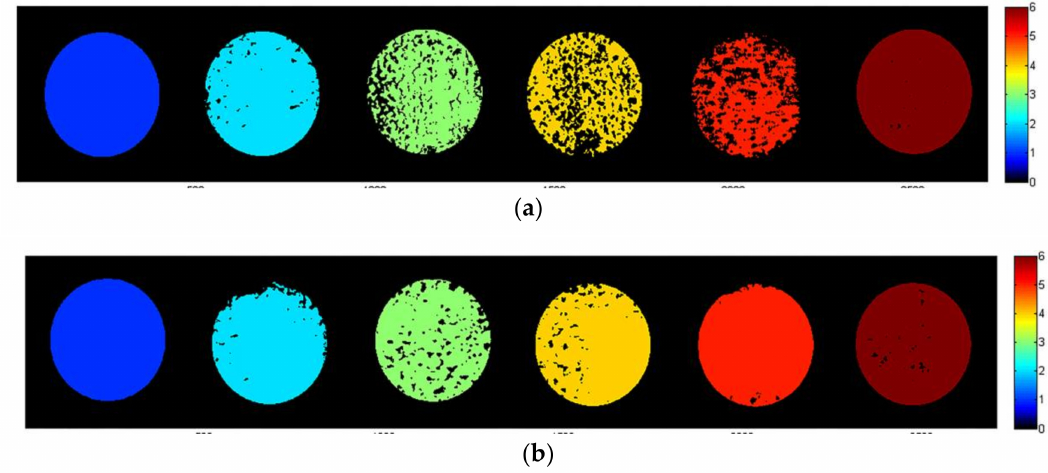
Figure 9. ( a ) Prediction images of A. flavus and ( b ) prediction images of A.